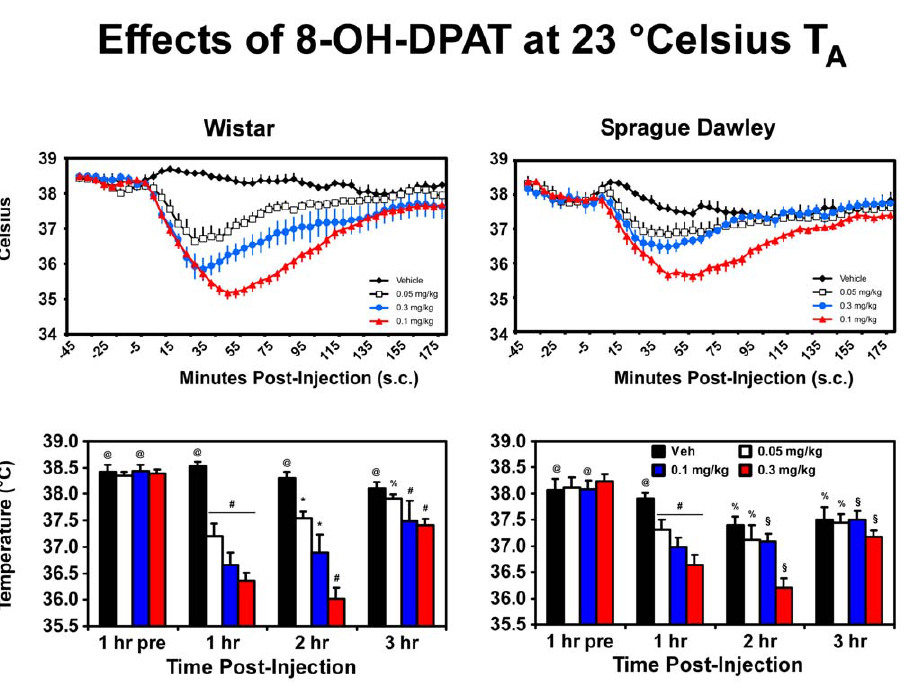
Figure 4. Mean ( ± SEM) body temperature is presented for Wistar (N=7) and Sprague-Dawley (N=7) rats following challenge with 8-OH-DPAT under 23 6 C T A conditions. Data were collected at 5 minute intervals (upper panels) and are analyzed as hourly averages (lower panels). A reliable difference between strains (only) is indicated by %; all other statistical conventions are as outlined in Figure 2.